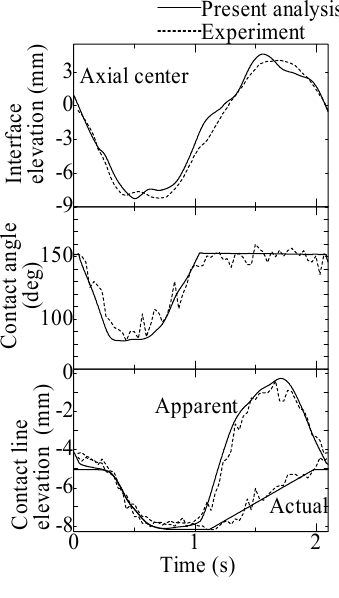
Fig. 8 Interface displacements and inclination angle in one cycle of excitation.